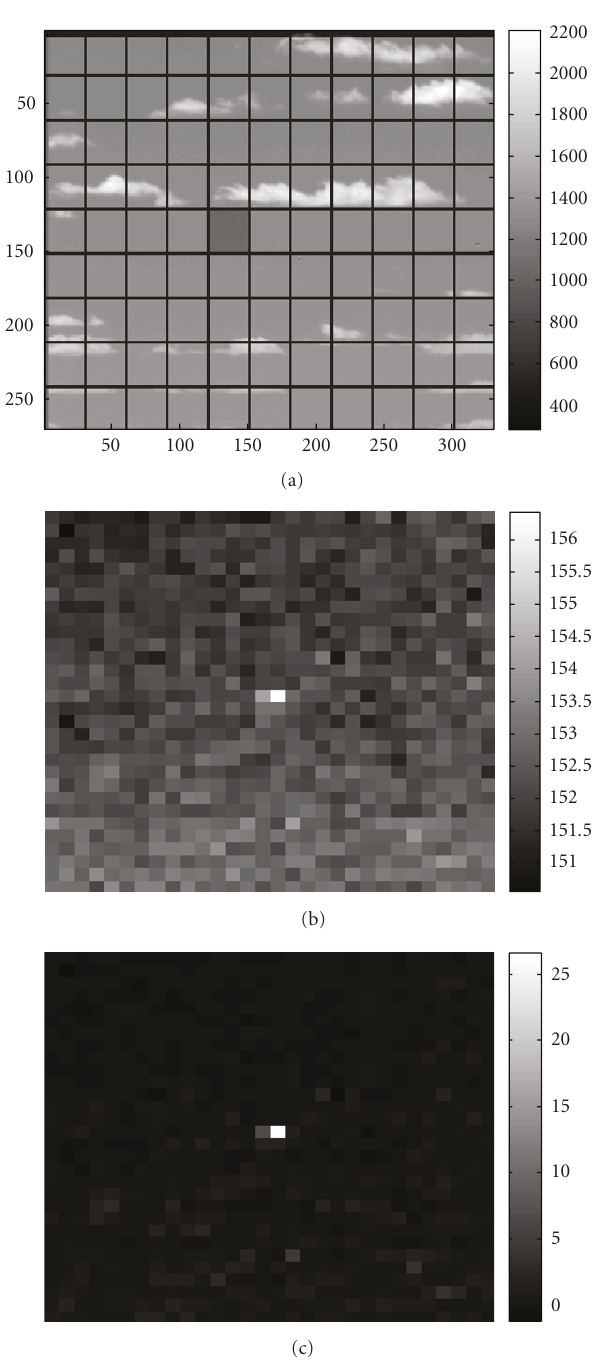
Figure 8: Algorithm stages. (a) 1st frame of the original NA23A sequence divided into blocks, (b) 1st frame of TB (target at center of frame), and (c) 1st frame of TB after the preprocessing whitening stage.